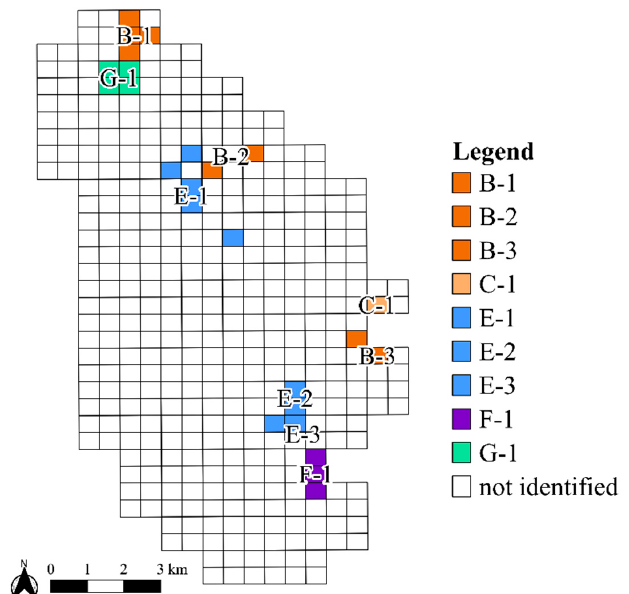
Figure 5. Distribution of the identified 25 grids in the Tsukuba Science City.